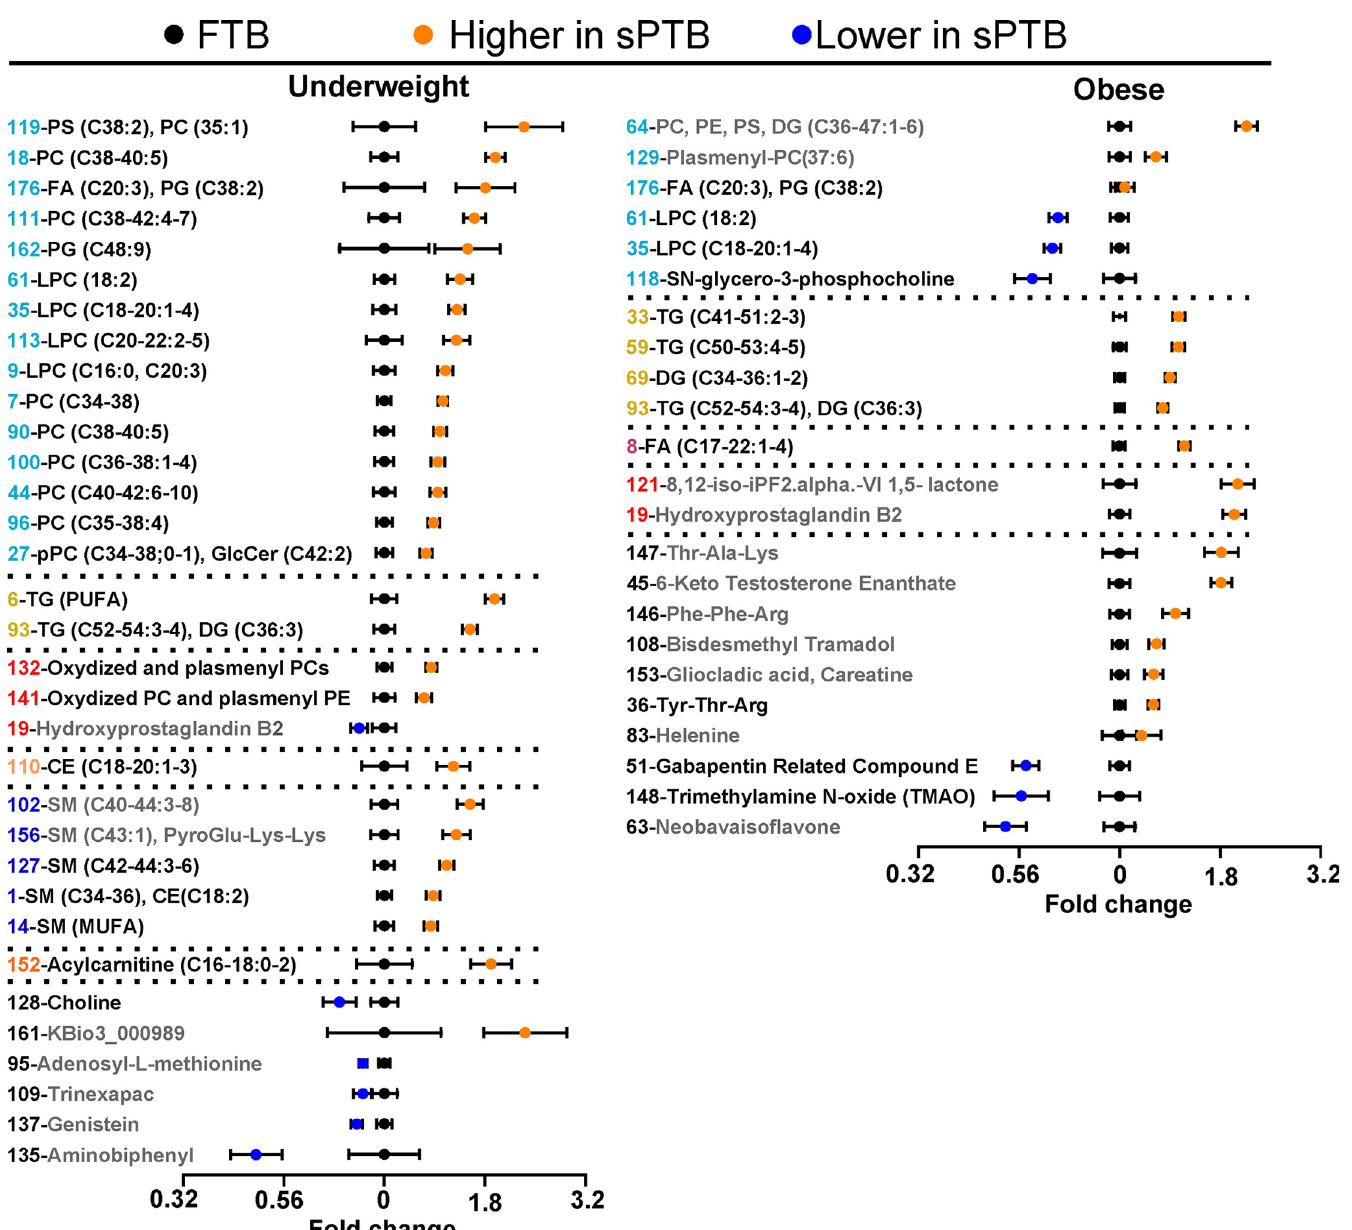
Fig 3. Differences in complex lipids and biogenic amines between sPTB and FTB deliveries. Results of the t-test analysis performed on variable cluster components, presented for women with underweight and obese BMI. Data are presented as the fold change from the FTB for each weight category. Each cluster is represented by a number and labeled with either a general description of variables within the cluster or the most representative metabolite. Clusters composed uniquely from metabolites identified only by parent mass (i.e. MSI level 3) are colored gray and should be interpreted with caution. A complete list of metabolites within each cluster with group means, p-values and MSI level are provided in the S3 Table . All displayed variables have p < 0.05 and passed FDR correction at q = 0.2. PC–phosphatidylcholine; PE– phosphatidylethanolamine; PS–phosphatidylserine; TG–triglyceride: DG–diglyceride; CE–cholesterol ester; SM–sphingomyelin; CA–cholic acid; FA–Fatty acids. Clusters are colored according their lipid classes: phospholipids and lysophospholipids–light blue; TG–yellow; oxidized lipids–red; SM–blue; CE–light orange; FA– purple; acylcarnitine–dark orange. Description of complex lipids—(total number of fatty acids carbon atoms: total number of double bounds). Error bars represent standard error. N = 17 per